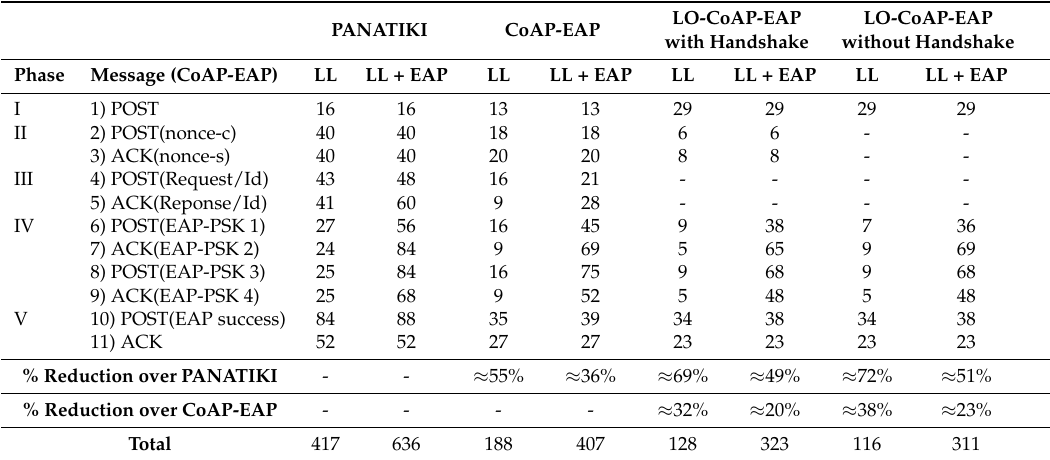
Table 2. Comparison of the message lengths. PANATIKI, PANA implementation of Contiki. PANATIKI